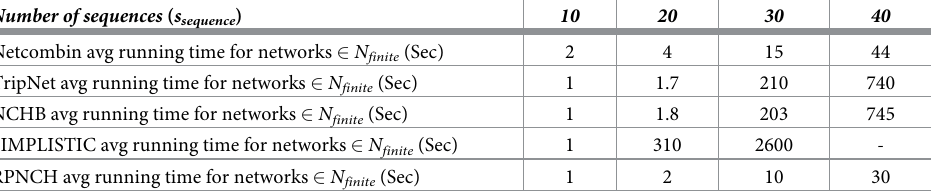
Table 2. The average running time results for the networks that belong to N finite for Netcombin, TripNet, NCHB, SIMPLISTIC, and RPNCH. Number of sequences ( s sequence )